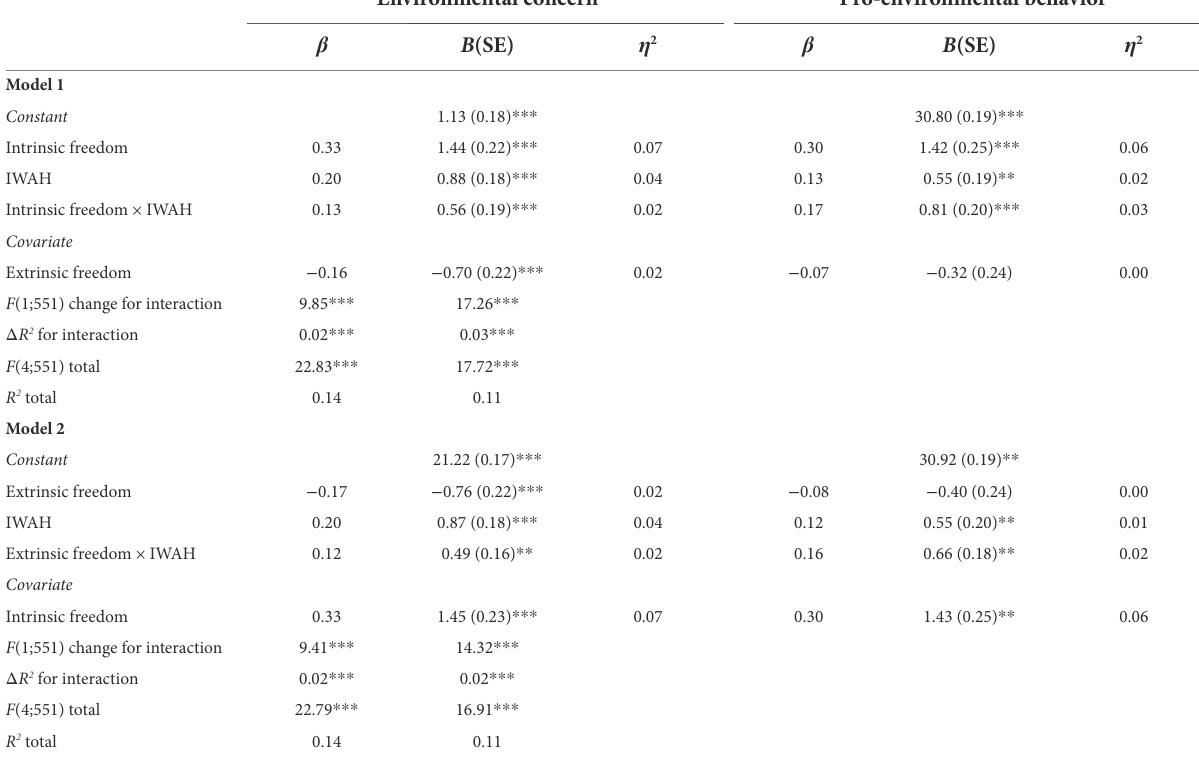
TABLE 2 Moderating effects of identification with all of humanity (IWAH) on the relations of intrinsic and extrinsic freedom with pro-environmental behavior and environmental concern. Environmental